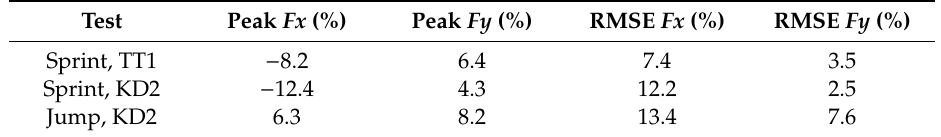
Table 2. Maximum peak value errors and root mean square error (RMSE) error for the three dynamic validations set of tests, in horizontal x and vertical y directions of the Global reference system.